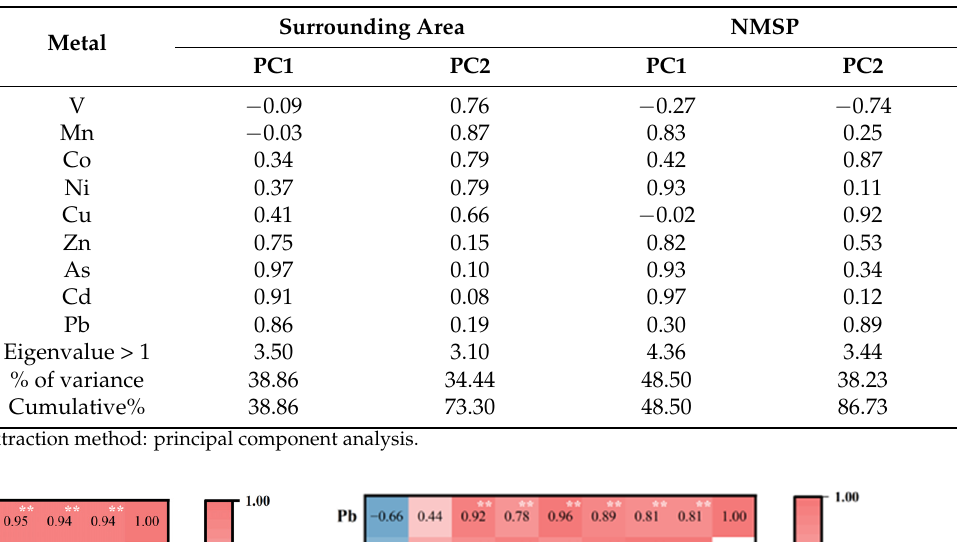
Table 2. Component matrix for heavy metals in soils of the surrounding area and non-ferrous metal smelting plant (NMSP).